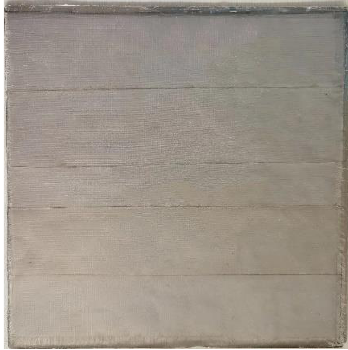
Figure 10. Quartz fiber and nanocrystalline reinforced resin matrix composite material.